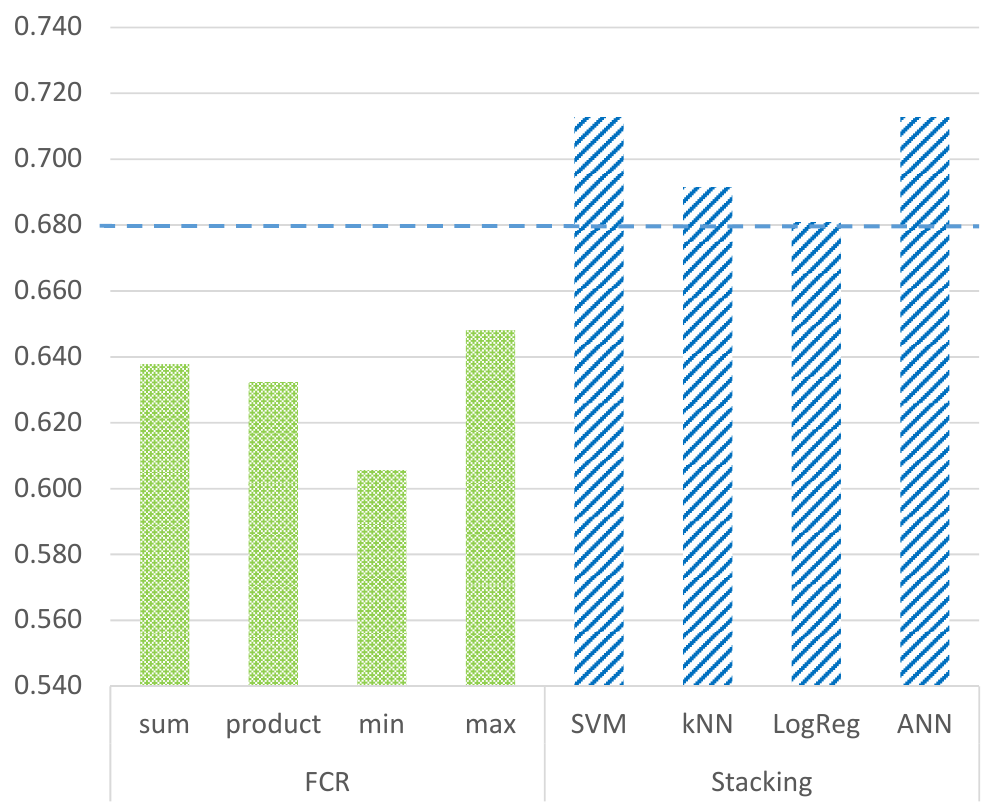
Figure 5. Performance of language independent ensemble classification (F1) by combining the two top ranked IPC and CPC base learners with different fusion methods: four different stacking classifiers as well four fixed-combinations rules (FCR) are applied. The dotted line marks the top performance value of the base learners.